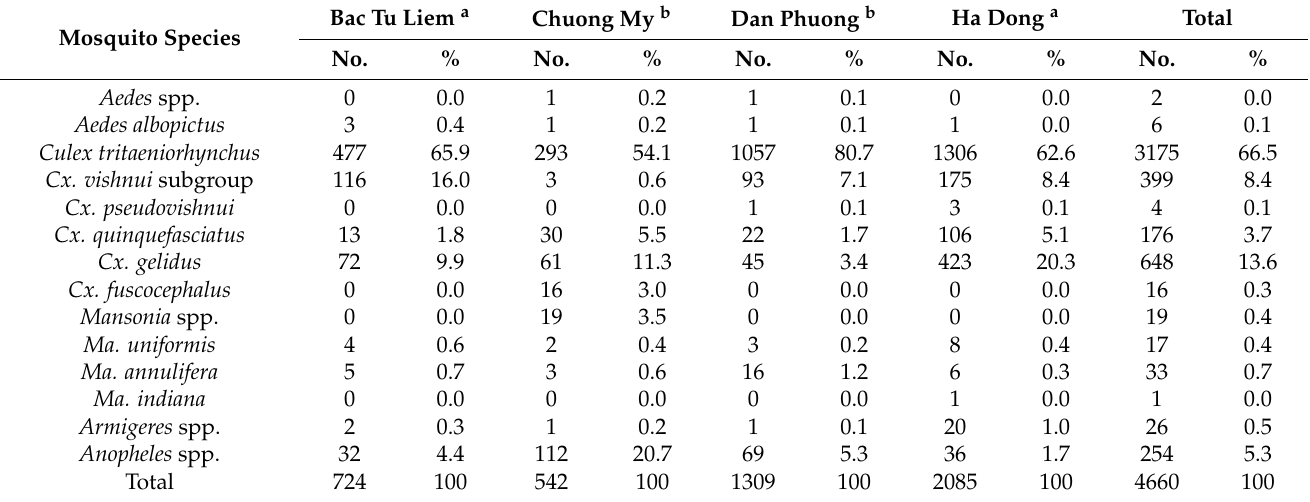
Table 7. Summary of mosquito species collected at pig pen—outdoor.